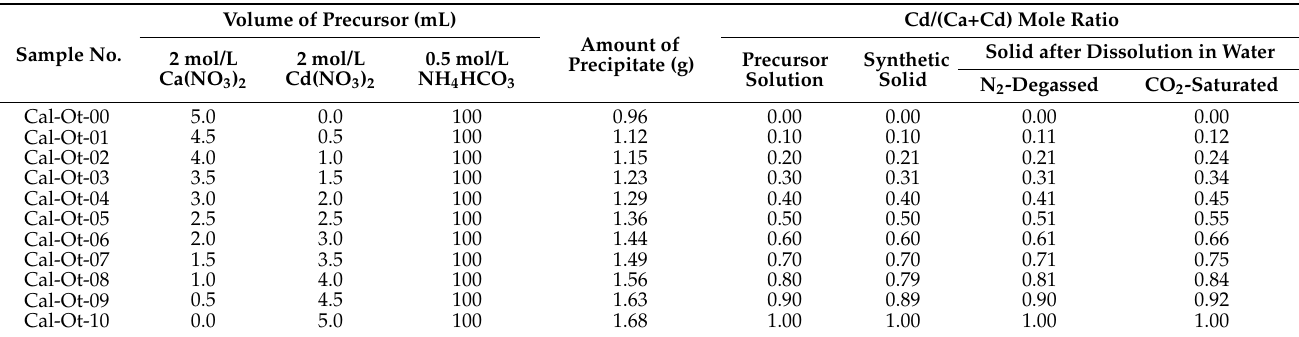
Table 1. Summary of synthesis and composition of the calcite–otavite solid solutions [(Ca 1 − x Cd x )CO 3